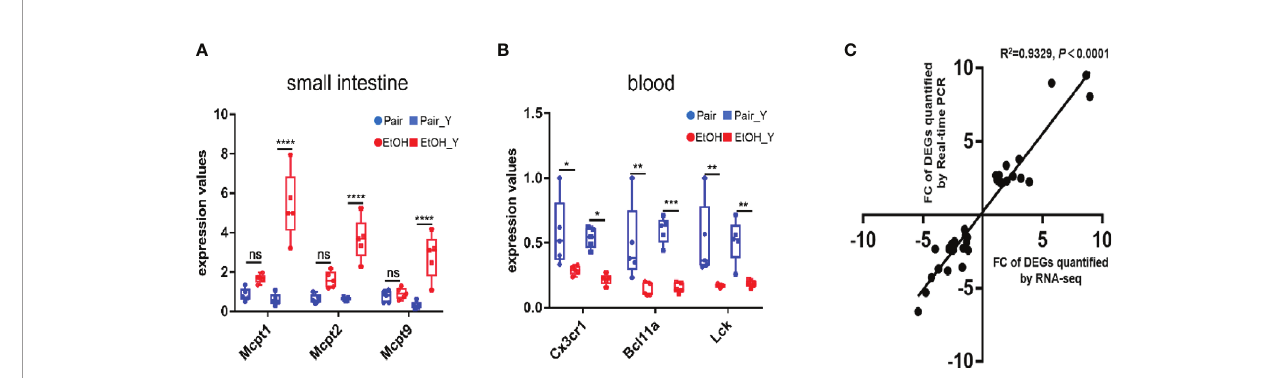
FIGURE 5 | RT-PCR analysisof DEGs. (A) RT-PCR results of DEGs in the smallintestine. The Mcpt1 , Mcpt2 , and Mcpt9 genes had higher expression levels inEtOH_Y than in Pair_Y (n= 5). (B) RT-PCR results ofDEGs in the blood. The Cx3cr1 , Bcl11a , and Lck genes hadlower expression levelsin EtOH_Y than Pair_Y(n = 5). (C) The correlationswere measured bydispersing the foldchanges ofDEGs between RNA-Seq and RT-PCR. (* P < 0.05, ** P < 0.01, *** P < 0.001, **** P < 0.0001). ns, nosigni fi